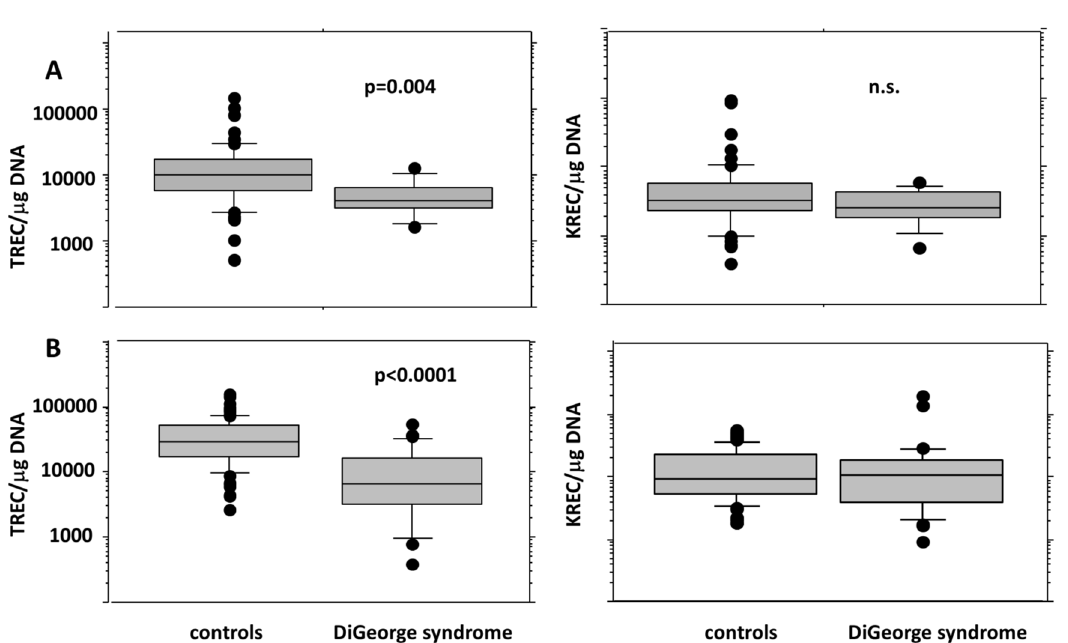
Figure 2. Quantitative TREC/KREC levels expressed as number of copies per microgram of DNA in A) neonatal dry blood spots B) peripheral blood for control children vs. children with DiGeorge syndrome (0–18